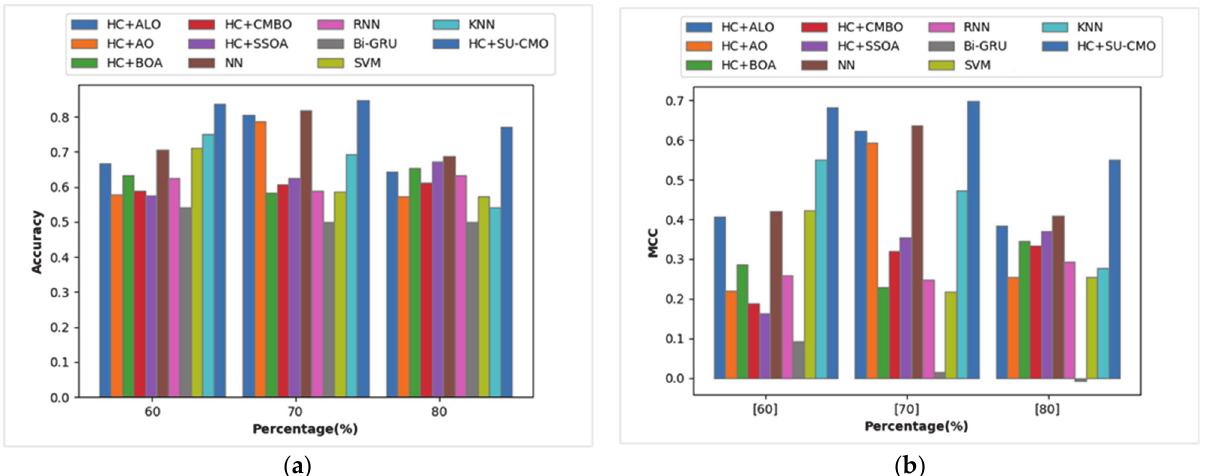
Figure 3. Performance of the adopted model over other existing schemes for dataset 1 ( a ) Accuracy ( b ) MCC.